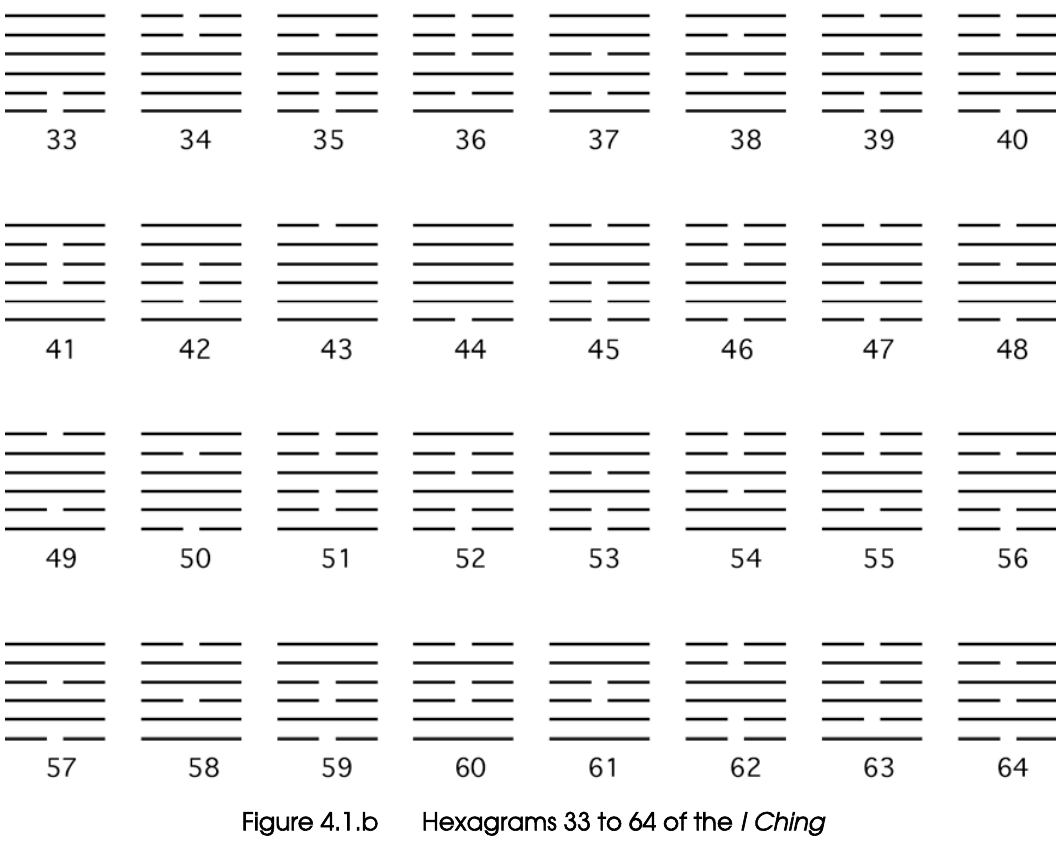
Figure 4.1.b Hexagrams 33 to 64 of the I